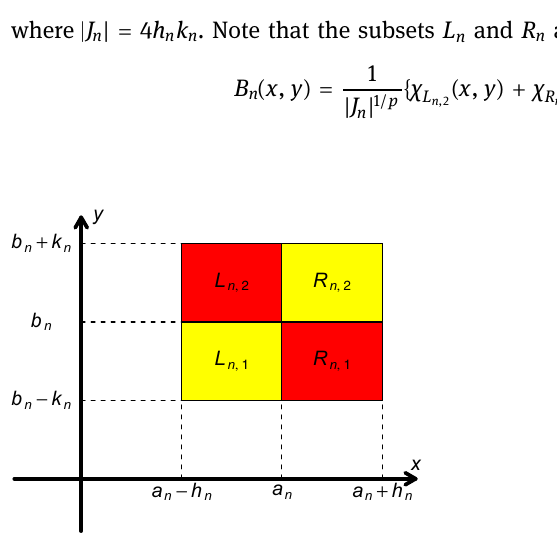
Figure 2: An illustration of L n and R n in the